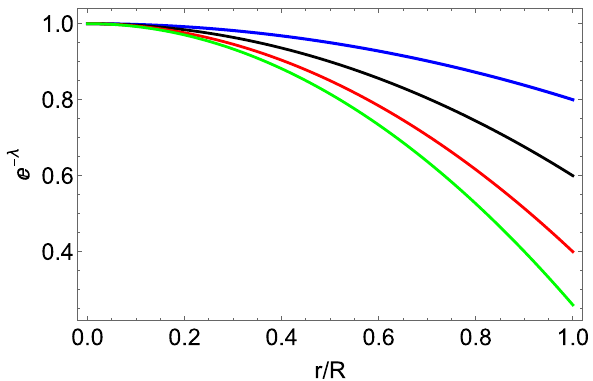
Fig. 1 e ν for u = 0 . 1 (blue line), u = 0 . 2 (black line), u = 0 . 3 (red line), u = 0 . 37 (green line) and (cid:13) = 1